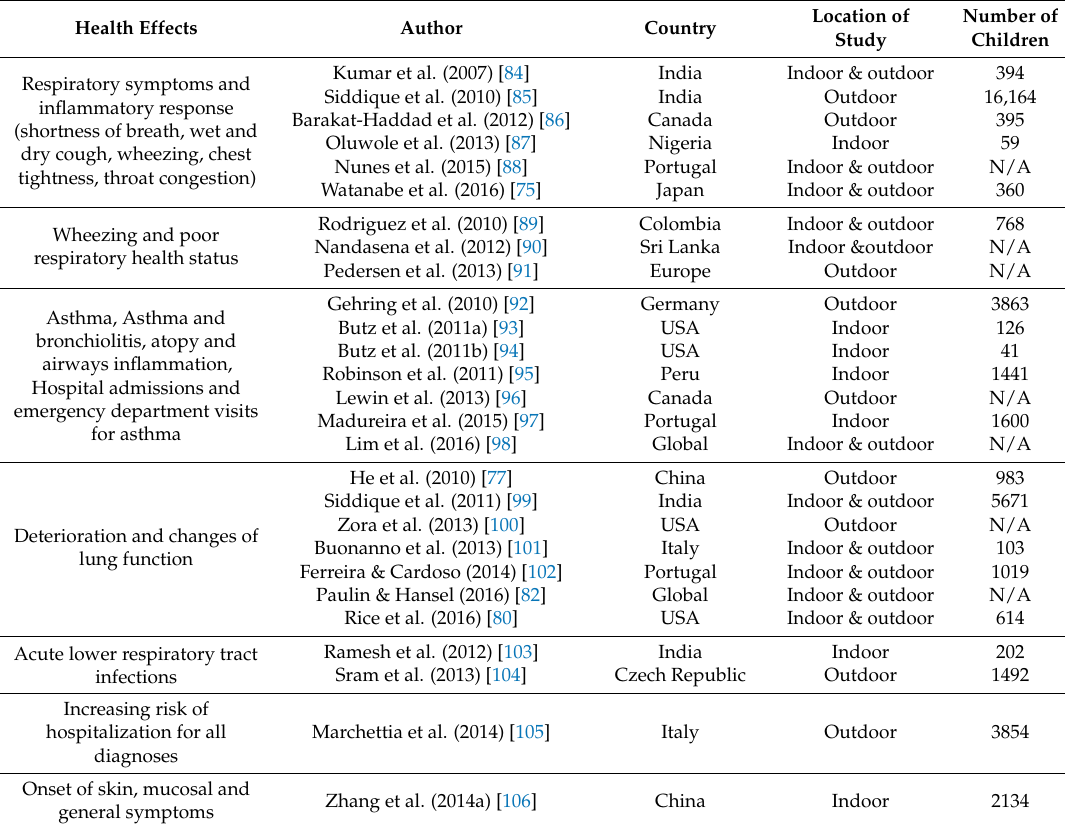
Table 2. Summary of particulate matter health effects on young children’s respiratory symptoms and diseases extracted from selected articles based on eligibility criteria and best judgment of paediatric experts (more details in Table